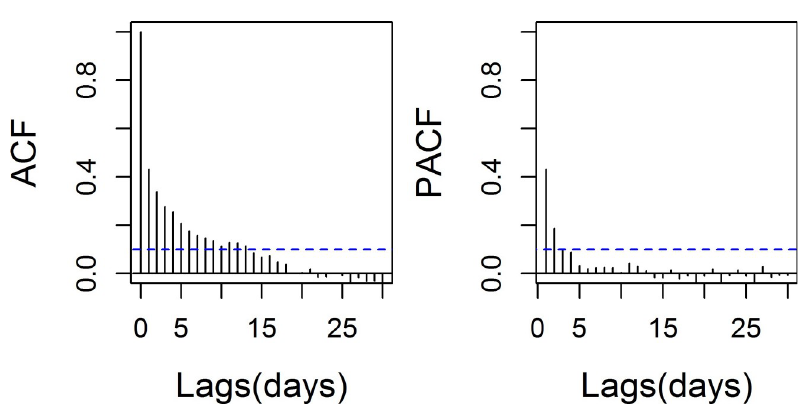
Fig 4. Autocorrelation function (ACF) and partial autocorrelation function (PACF) of GAM (df t = 20 and df temp = 5).